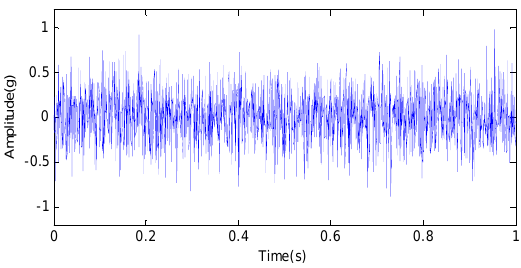
Figure 21. The simulated signal sample with White Gaussian noise.